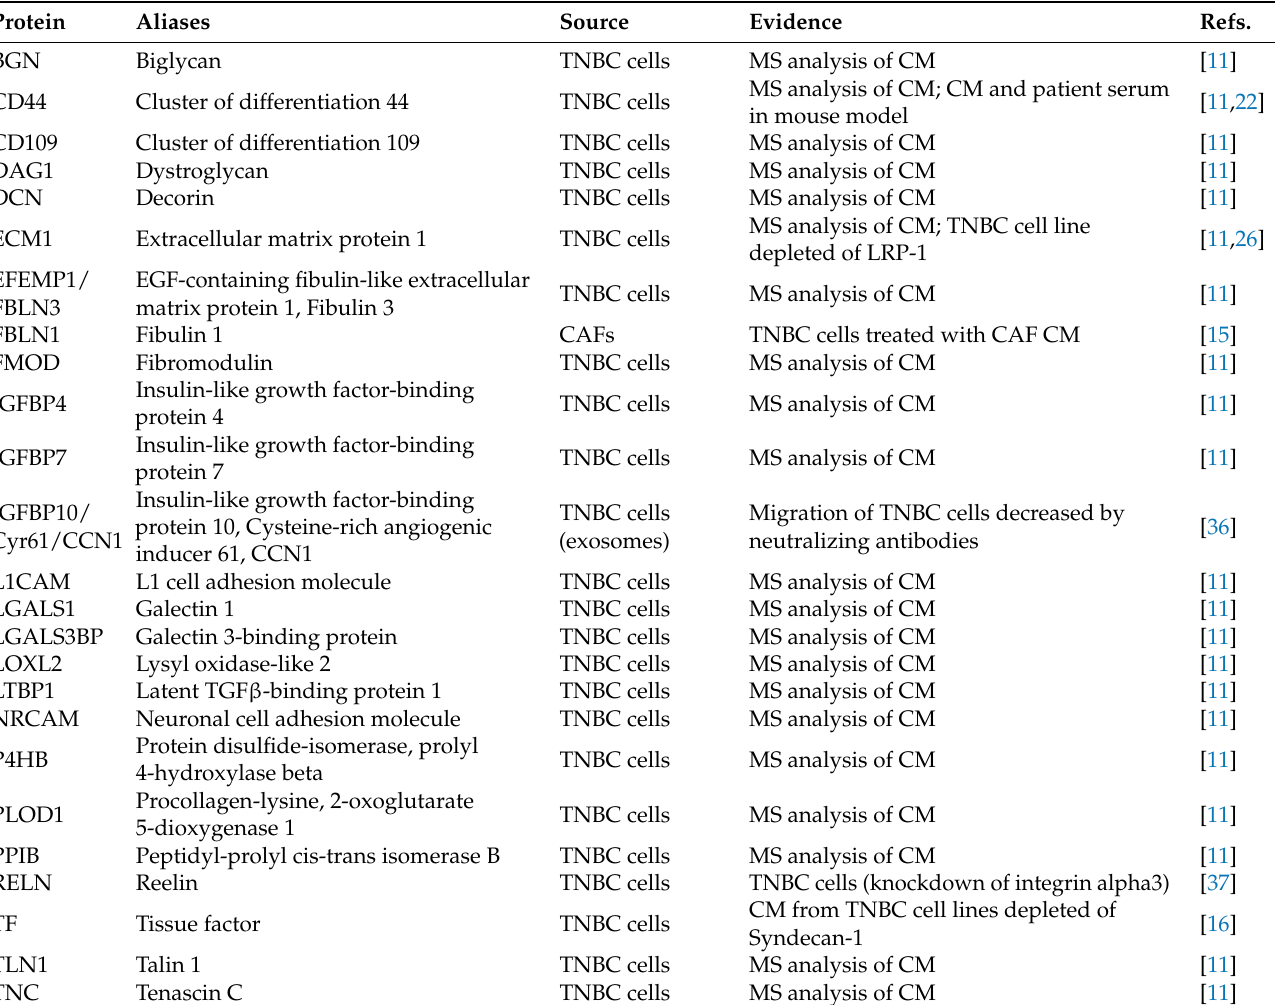
Table 2. Extracellular Matrix Proteins of the TNBC